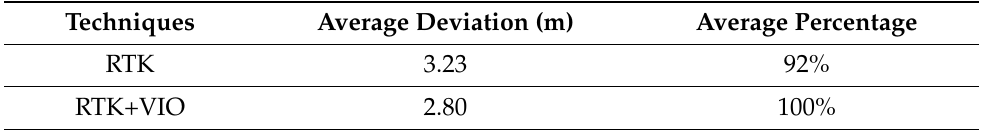
Table 6. The deviation and the percentage of valid positioning results.